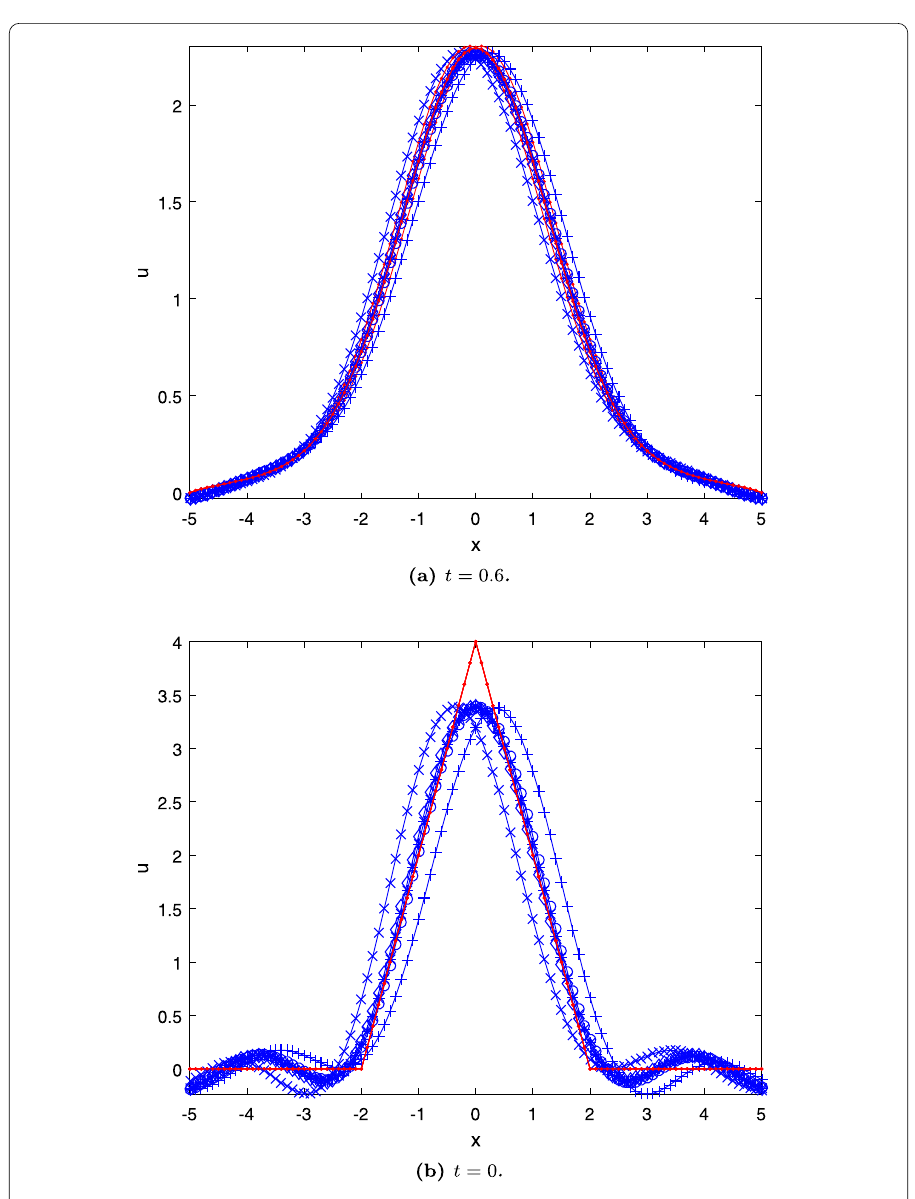
Figure 3 At t = 0.6 and 0, α = 1.5, s = 2, γ = 0.1, ε = 0.01: Exact and regularized solutions for different θ . Point: exact solution; Star: regularized solution with θ = 0 and μ = 2.8407e–04; Loop: θ = 0.01 and μ = 2.8439e–04; Plus: θ = 0.1 and μ = 2.9321e–04; Diamond: θ = –0.01 and μ = 2.8389e–04; Multiplication: θ = –0.1 and μ = 2.8831e–04